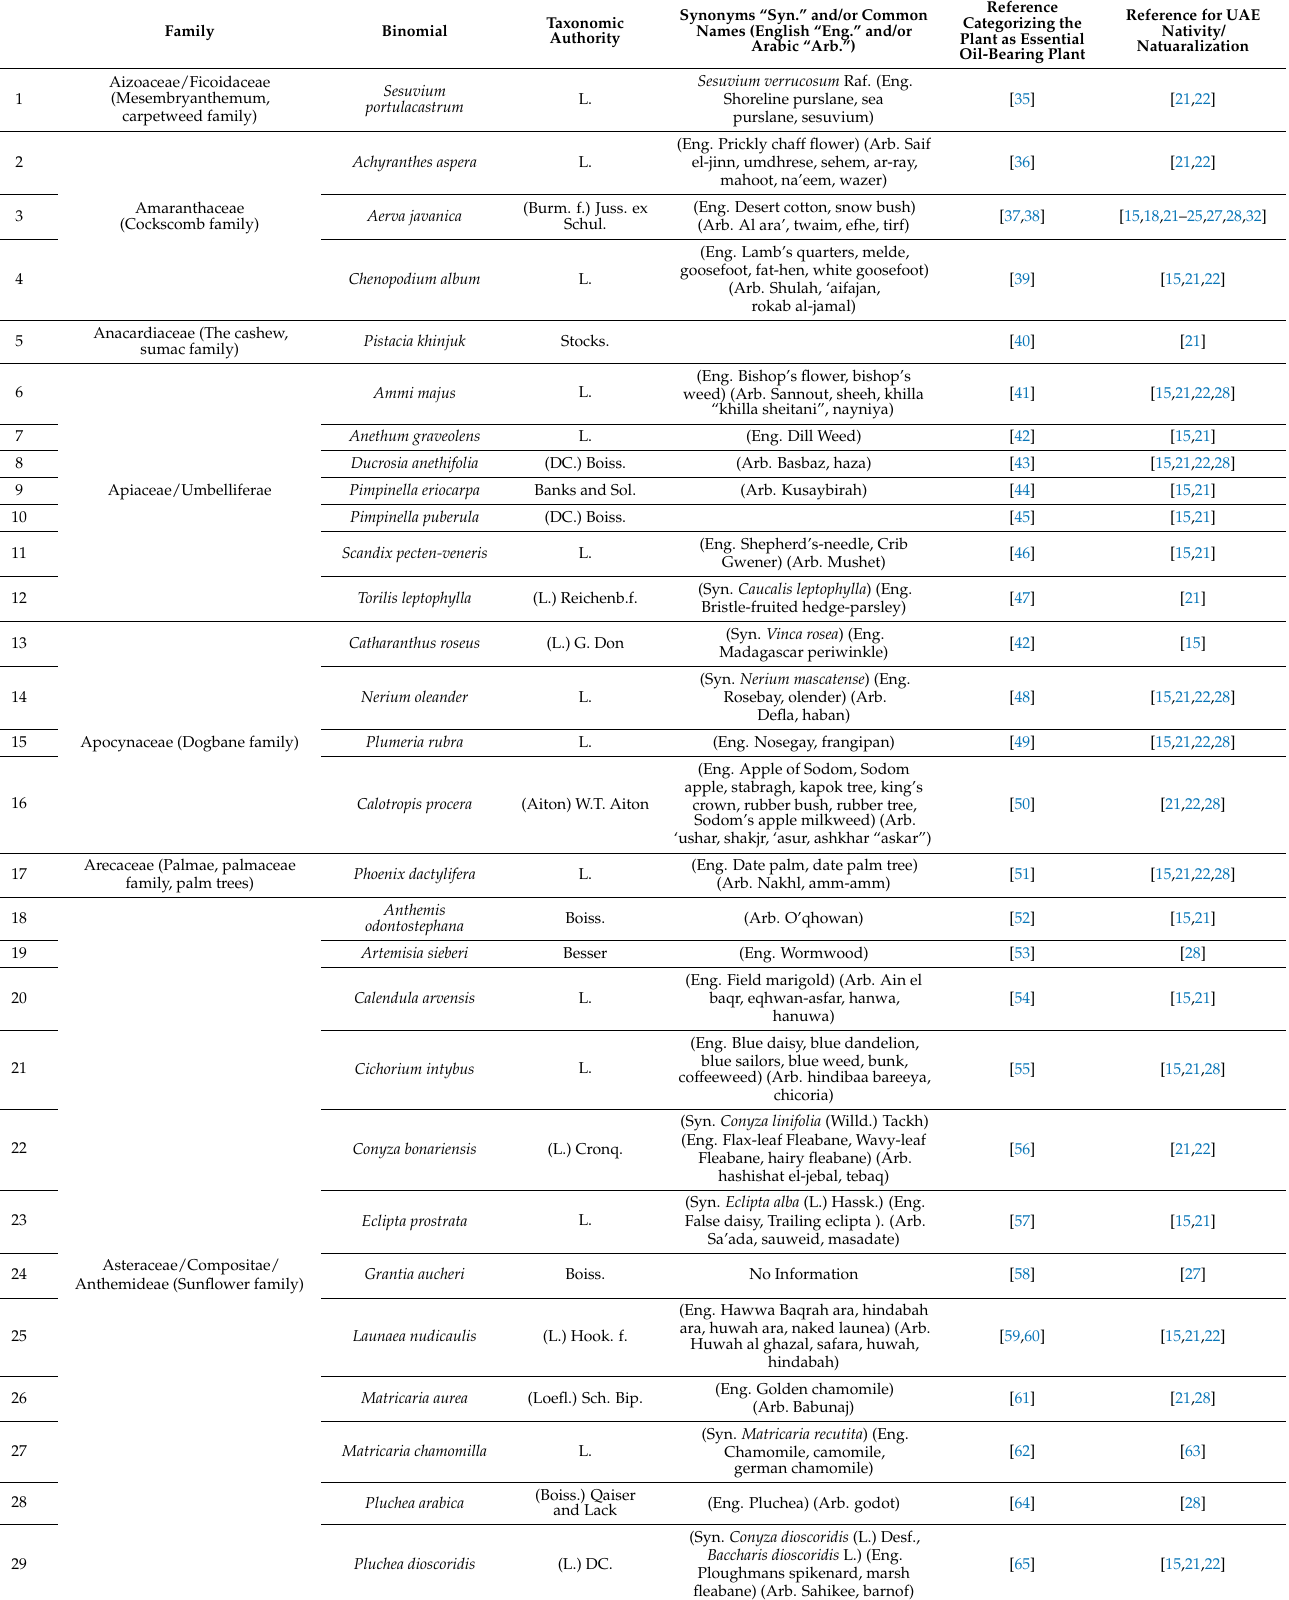
Table 1. An overview of indigenous and naturalized essential oil-bearing plants of the UAE. Family Binomial Taxonomic Authority